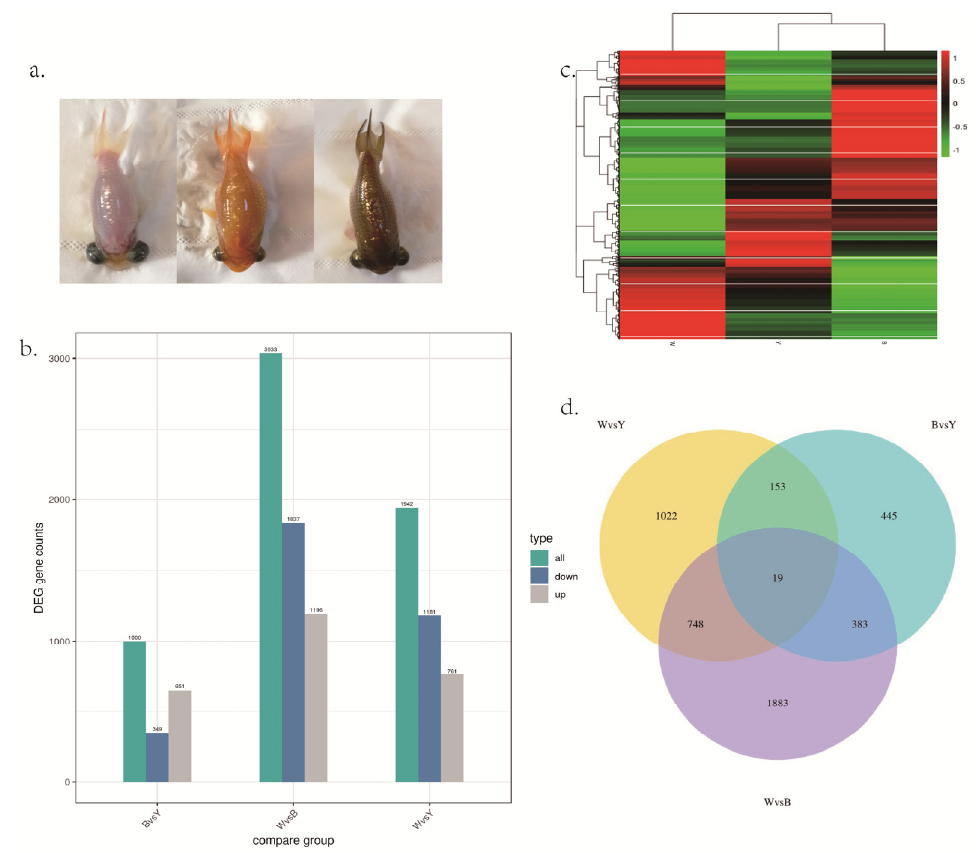
Figure 1. ( a ). The different skin colors in the celestial goldfish. Left: white (W); center ： yellow (Y); right: brown (B). ( b ) The bar graph of number of DEGs among three different skin colors. ( c ) Clustering heat map of DEGs in the three skin color groups. ( d ) DEGs number and Venn diagram of the overlap of the different skin color groups. W: white; Y: yellow; B: brown.